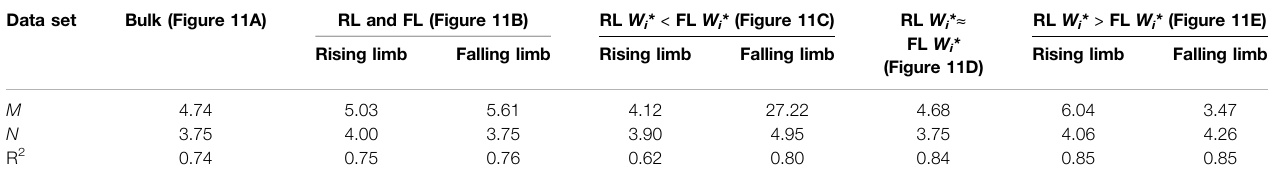
TABLE3| Valuesofparameters m,n andthecorrelationcoef fi cient R 2 forthebest- fi tcurvewhenapplying Eq.4 tostandardbulkandlimb-separateddatasets(i.e., Figures 11A,B ) and our hysteretic mode-separated datasets ( Figures 11C – E ), in which sediment transport hysteresis modes are also taken into account (Note: RL for rising limb; FL for falling